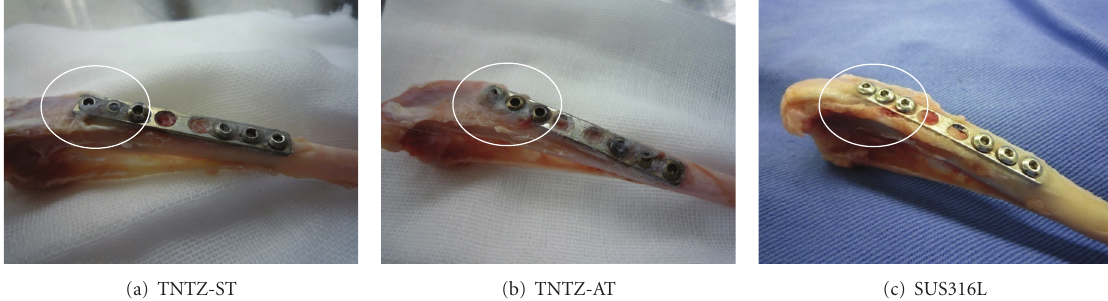
Figure 19: Profiles of extracted bone plates made of (a) TNTZ-ST, (b) TNTZ-AT, and (c) SUS316L stainless steel fixed to tibiae of rabbits at 52 weeks after